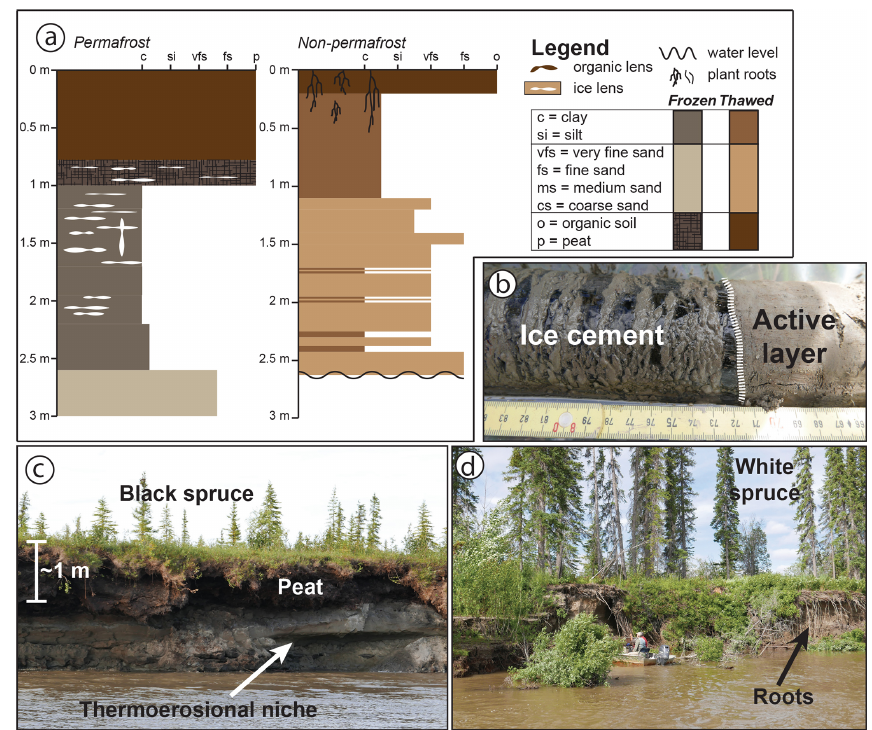
Figure 3. Field observations of Koyukuk riverbanks and floodplain stratigraphy. (a) Representative stratigraphic columns from non- permafrost (Bank 2) and permafrost (Bank 6) cutbanks. (b) Field photo of boundary between permafrost ice cement and the overlying active layer in Core 4. (c) Thermoerosional niche formed in a permafrost cutbank, with silty permafrost overlain by a layer of peat and black spruce trees. (d) Eroding riverbank without permafrost, hosting a white spruce forest with roots that reach deep into the bank sediment. Complete stratigraphic sections and additional field photos are in Figs. S2 and